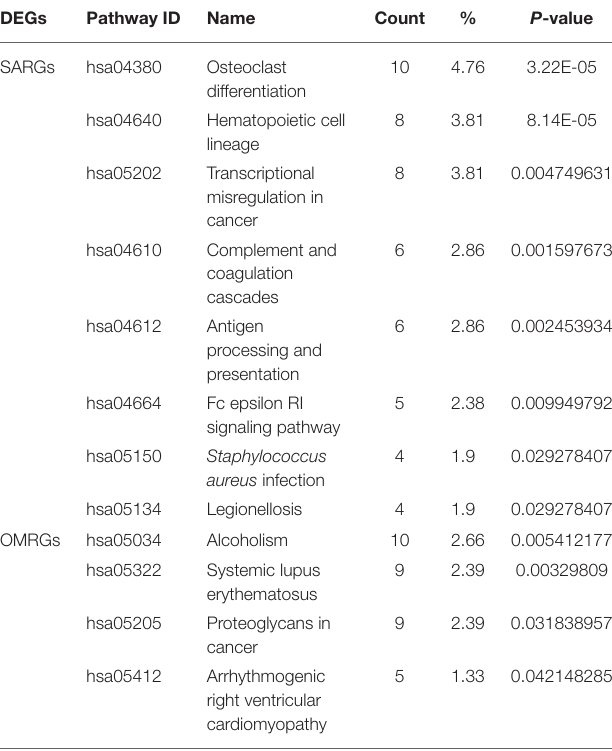
TABLE 2 | KEGG pathway enrichment analysis of the SARGs and OMRGs (the top pathway terms).